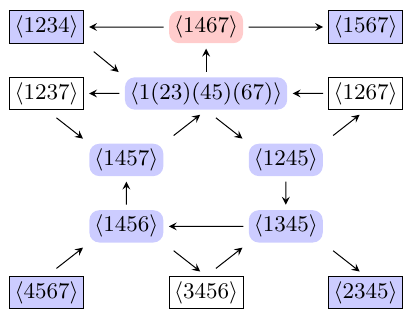
Figure 23. A cluster corresponding to the 4 th term in A 7 ; 2 .